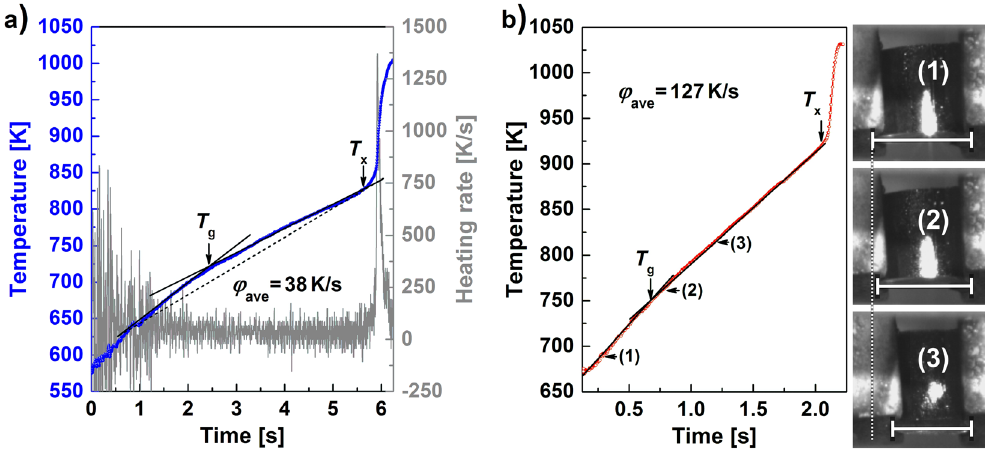
Figure 3. Temperature-time curve of BMG specimens (Ø = 4.5 mm, h = 4 mm) during flash-annealing. ( a ) Representative temperature-time heating curve and its derivative for a Zr 52.5 Cu 17.9 Ni 14.6 Al 10 Ti 5 BMG specimen flash-annealed at ϕ ave = 38 K/s to T ej = 1005 K. The intersection of the two linear fits marks the glass-transition temperature, T g , and the beginning of the steep temperature increase indicates the crystallization temperature, T x . ( b ) Heating curve of a Cu 44 Zr 44 Al 8 Hf 2 Co 2 BMG specimen ( ϕ ave = 127 K/s) to which a load is applied during heating. Snapshots of a high-speed camera show that the shape of the specimen starts to change at temperatures higher than the intersection. The specimen is deformed more and more and hence the intersection of both linear fits marks T g .